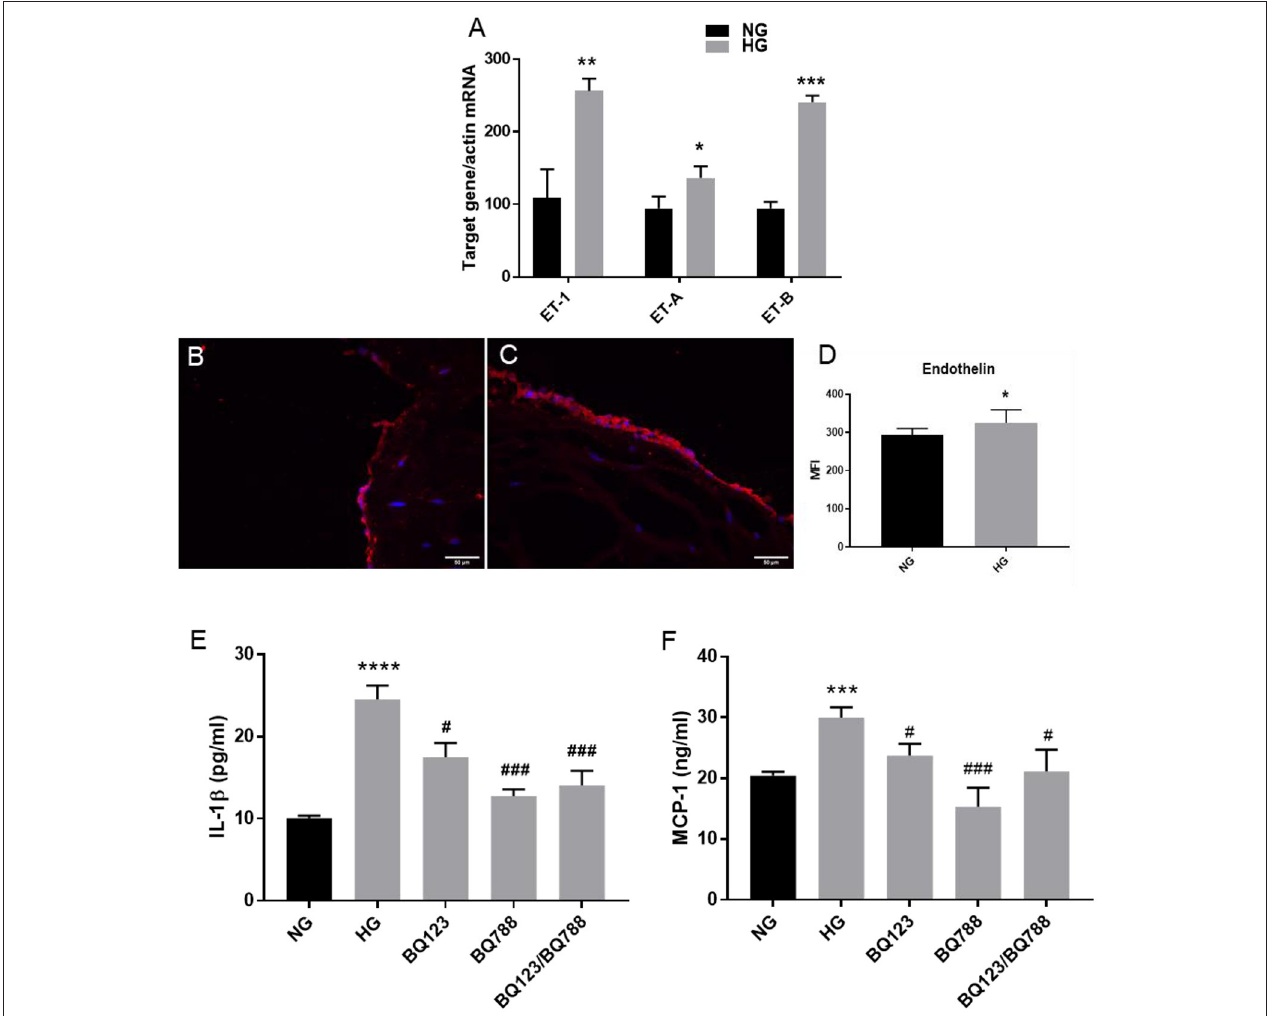
FIGURE 6 | Endothelin-1 expression is increased by HG levels in VEC; inhibition of endothelin-1 receptor A/B with the specific inhibitors BQ123, BQ788 decreased the secretion of inflammatory molecules IL-1 β and MCP-1. (A) Gene expression of ET-1 and ET-1 receptors (ET-A and ET-B) in VEC isolated from 3D-constructs after 7 days of normal (control) and high glucose exposure, as evaluated by Real-Time PCR. n = 3. (B,C) Representative images of ET-1 protein expression, as evaluated by immunofluorescence. Cryosections were stained with ET-1 primary antibodies and Alexa coupled secondary antibodies (red staining). Nuclei were stained with DAPI (blue staining). (D) Protein expression of ET-1 in valvular cells - mean fluorescence intensity of images was calculated for the fluorophore and normalized to the number of cell nuclei stained with DAPI. (E,F) Soluble MCP-1 and IL-1 β protein secreted in the conditioned media by VEC from 3D-construct exposed to